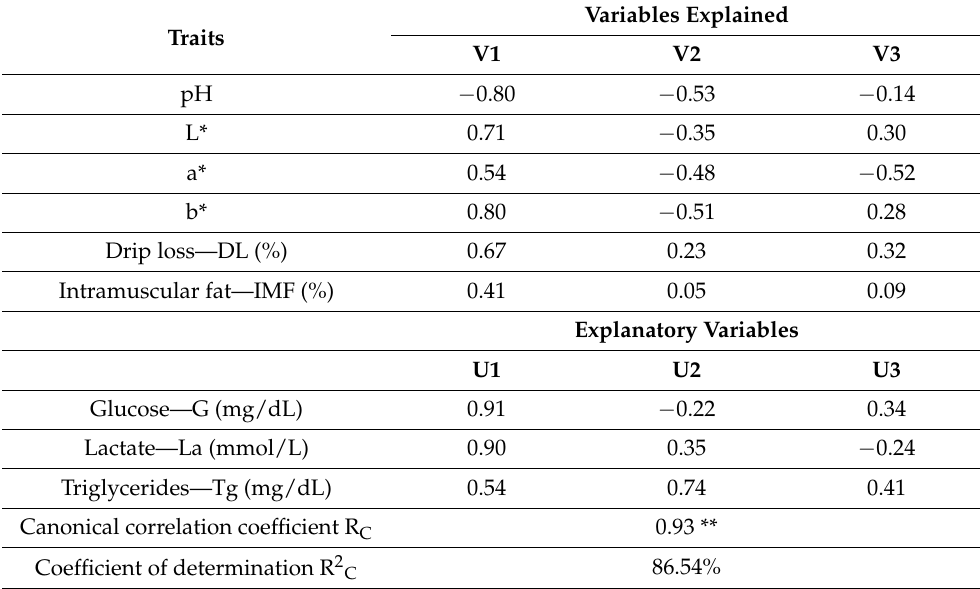
Table 3. The results of the canonical analysis: factor structure.